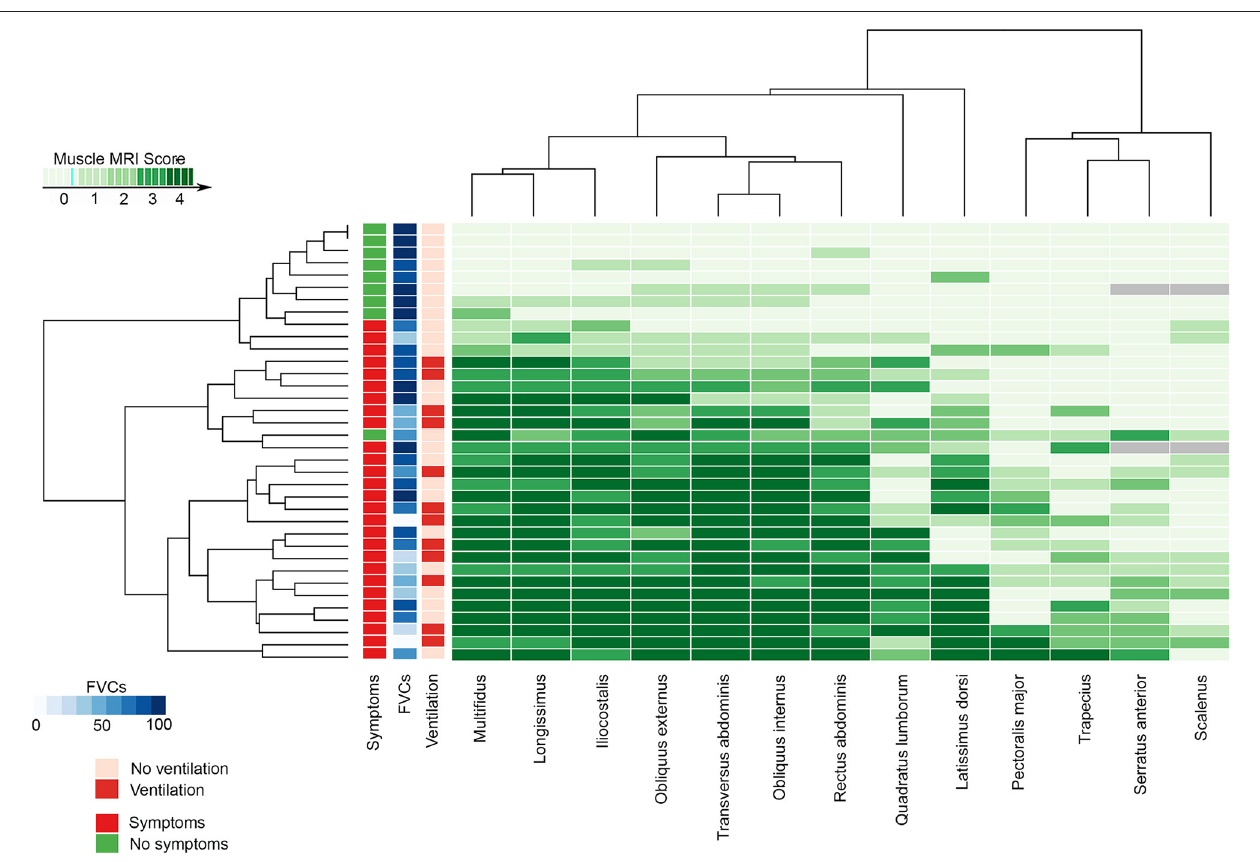
FIGURE 3 | The heatmap shows the MRI Mercuri score value for all the muscles studied, the presence of muscular weakness (symptomatic) or hyperCKemia alone (no symptomatic), its relationship with the FVC at base time, and the needs of noninvasive mechanical ventilation in every patient. FVC, forced vital capacity; MRI, magnetic resonance